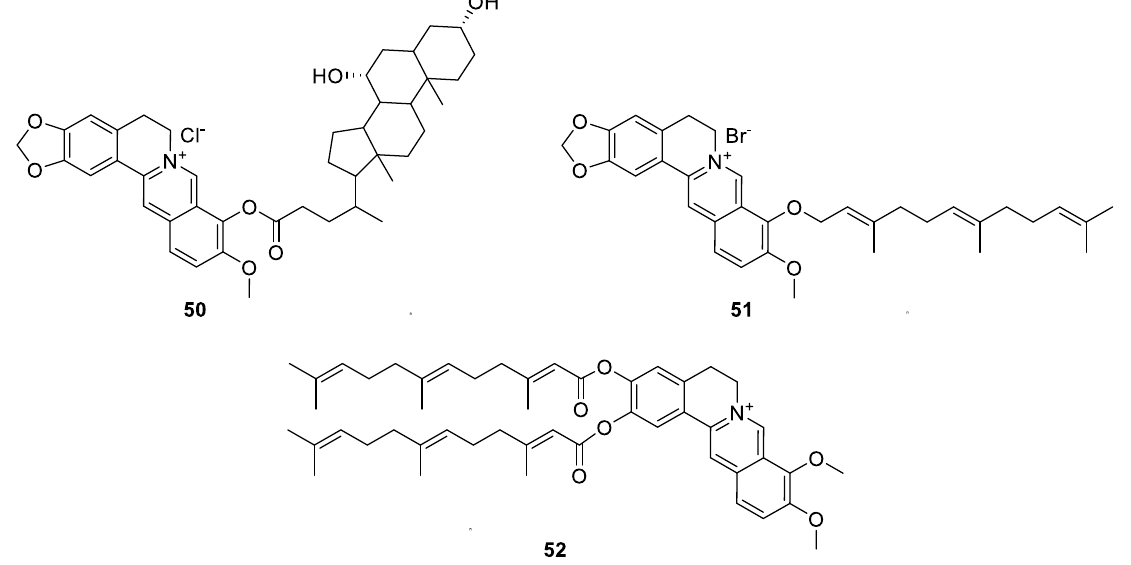
Figure 6. Other berberine hybrids [139 – 141].